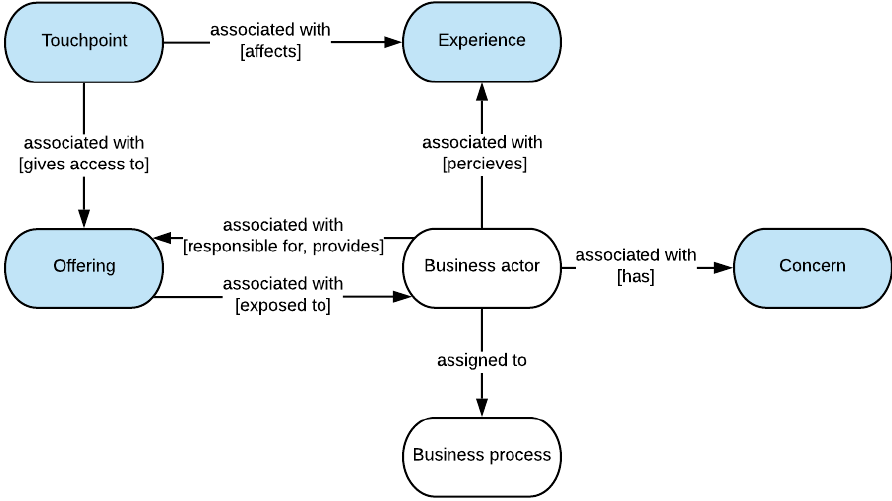
Figure 10. Customer journey focal with included